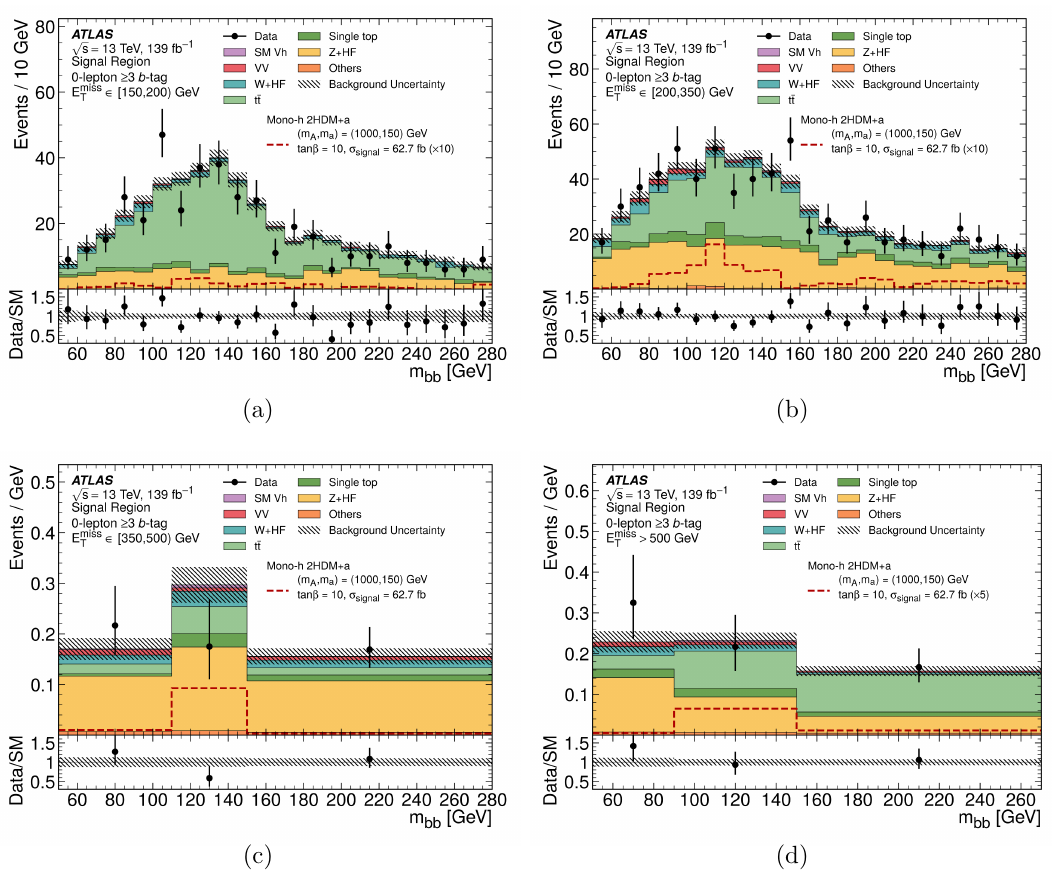
Figure 5. Distributions of the Higgs boson candidate mass in the ≥ 3 b -tag signal regions. The top panel compares the fitted background yields with data, while the bottom panel indicates the ratio of the observed data to the predicted Standard Model backgrounds. The background yields are obtained in a background-only fit to data. An example signal model from the 2HDM+ a with bbA production and with parameters ( m A , m a ) = (1000 GeV , 150 GeV ) , tan β = 10 , and a cross-section of 62.7 fb is displayed for comparison. The signal is scaled by the factors indicated in the legend for better